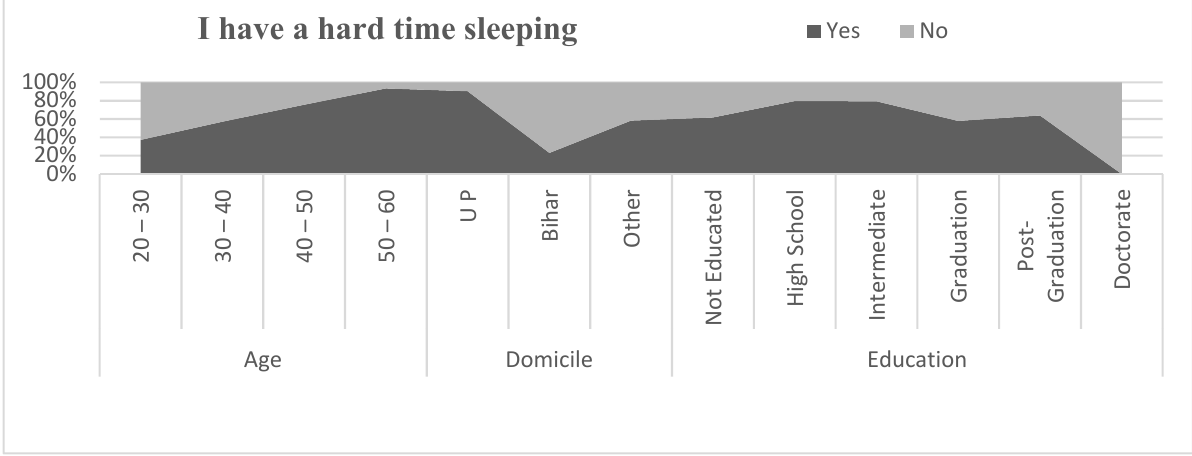
Figure 7. Comparison of hard time sleeping.